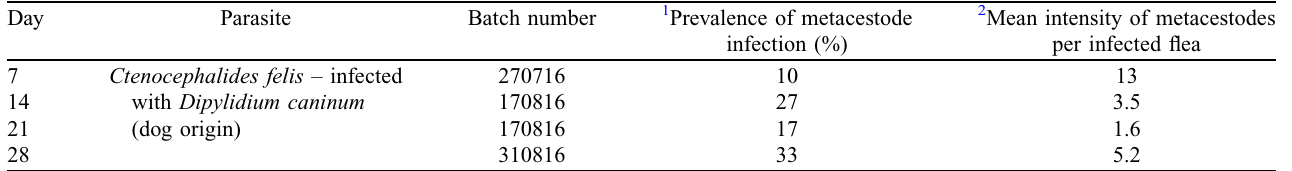
Table 3. Flea batches and infection rates used per